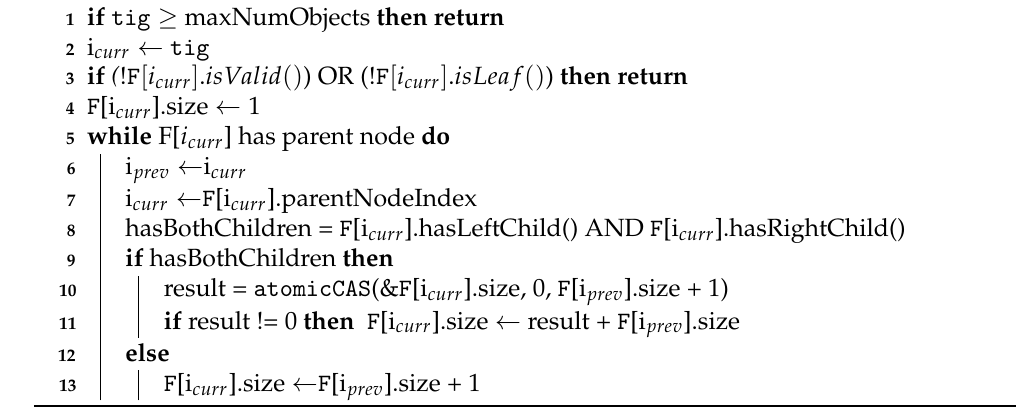
Algorithm 2: updateTreeSize( F ,